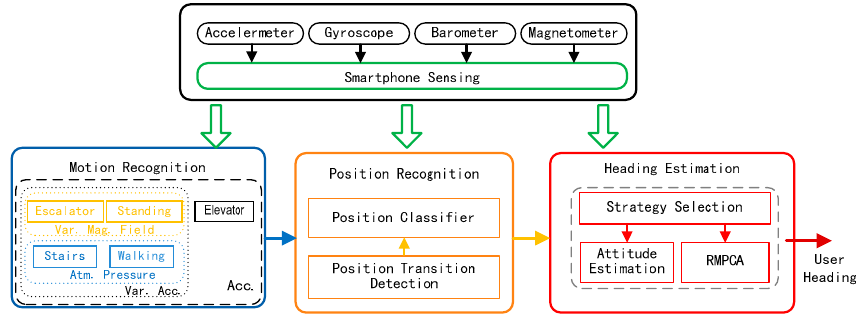
Figure 1. Overview of the proposed user heading estimation system.